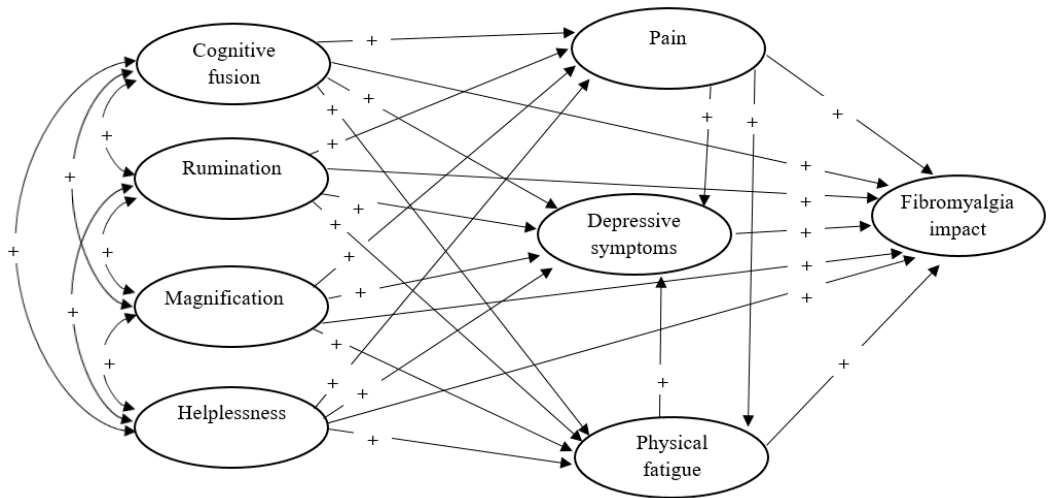
Figure 1. Hypothesized model of cognitive fusion and pain catastrophizing associations with fibromyalgia impact through physical fatigue, pain severity, and depression. The “ + ” symbol represents an expected positive association.